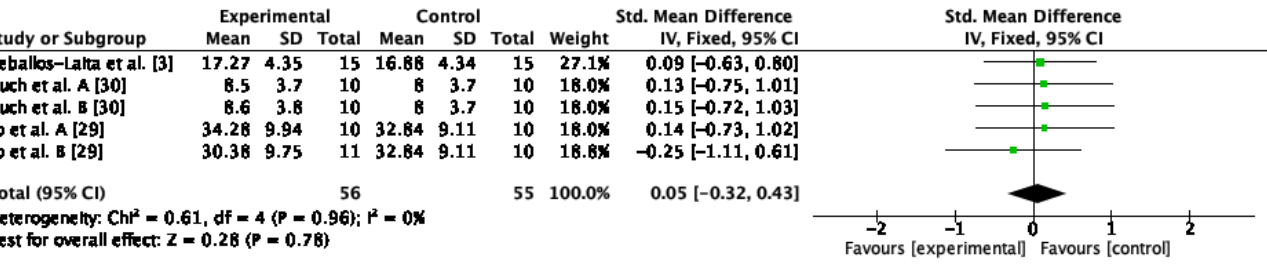
Figure 7. Forest plot of external rotation strength for conservative therapy versus control/sham. Lluch et al. A. compared manual therapy versus control intervention. Lluch et al. B compared the- manual contact versus control intervention. Lo et al. A compared KT versus control intervention. Lo et al. B compared stretching versus control intervention.